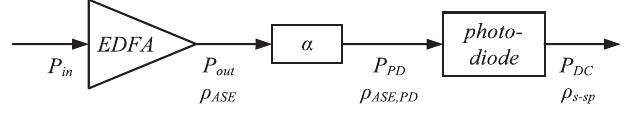
FIG. 11. Noise through optical